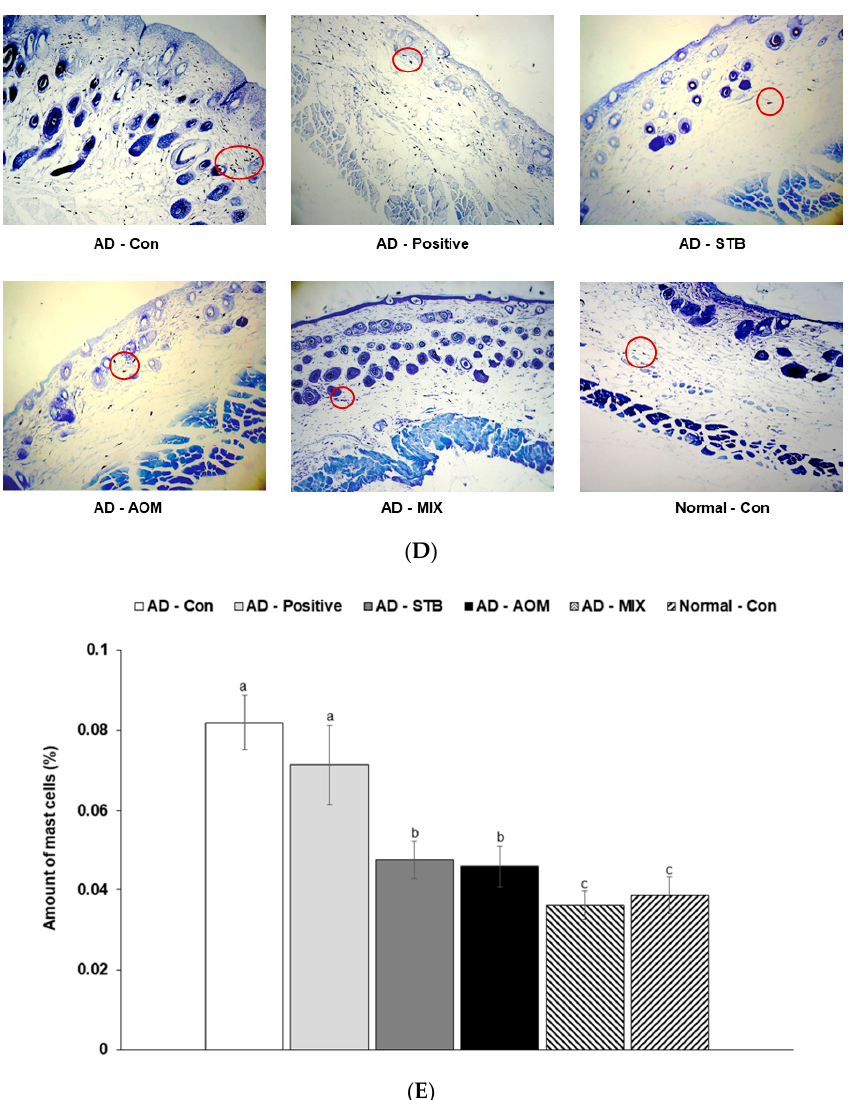
Figure 3. The histological differences and the number of mast cells in the dorsal skin. After the 5-week treatment, the dorsal skin was fixed with 10% formaldehyde, embedded in paraffin and then sections were made. The skin sections were stained with hematoxylin and eosin and toluidine blue staining. The magnification of the image was 100×. ( A ) The histology of the dorsal skin by hematoxylin and eosin staining. ( B ) The thickness of the epidermis ( E ) and dermis ( D ) indicated by blue lines (unit: µm). Total indicated by the sum of epidermis and dermis thickness. ( C ) The abnormality of keratocytes and skin surface indicated by a red arrow. The larger the score, the more abnormal the cell and nucleus shapes, the more spacing between keratocytes and the rougher the skin. ( D ) Mast cell staining by toluidine blue. The mast cells were indicated by the red circles. ( E ) The number of mast cells recognized as blue dots marked by red circles (% of mast cells of the skin tissue area). Each value represents the mean ± SD of 8 mice in each group. a,b,c Means with different superscripts were significantly different among the groups in each parameter by Tukey test at p < 0.05.